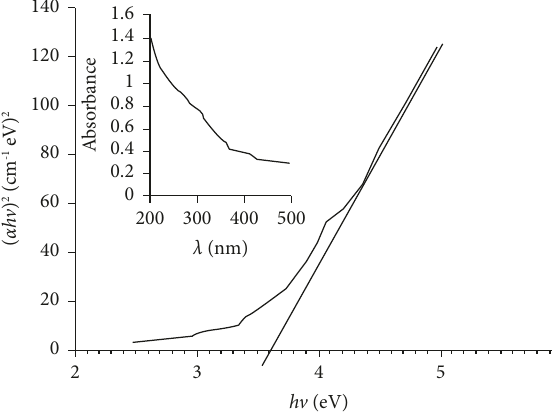
Figure 3: The relation between ( α hv ) 2 and ( hv ) of TiO